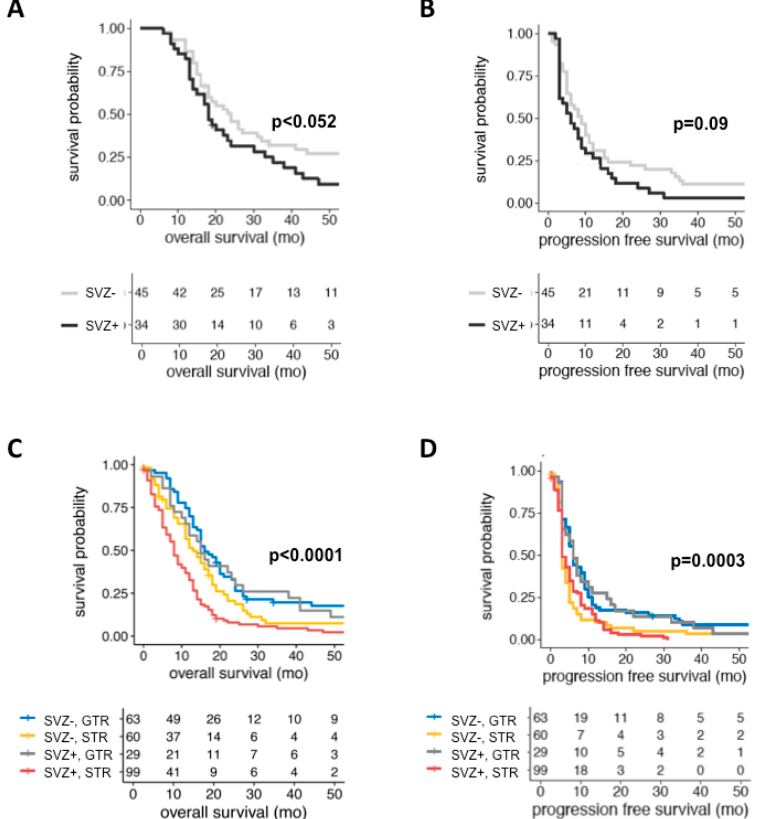
Figure 4. When analyzing IDH1-wt GBM patients with intensified adjuvant treatment (i.e., completion of concomitant radio-chemotherapy and ≥ 3 cycles of TMZ-based chemotherapy) only ( n = 79), absence of radiographic SVZ involvement conferred a non-significant, but meaningful prolongation of OS (24 vs. 18 months; A ) and PFS (9 vs. 6 months; B ) that also compared favorable to the outcomes of the most recent “historic control” derived from a multicenter trial on tumor-treating fields in newly diagnosed GBM [36] (OS = 16 months; PFS = 4 months; data not shown). ( C , D ) Kaplan-Meier plots depicting the prognostic significance of SVZ involvement in 285 IDH1-wt GBM patients on OS ( C ) and PFS ( D ) when stratified for EOR. Noteworthy, the negative prognostic impact of SVZ involvement can be, in part, resolved by GTR since OS and PFS were comparable in patients undergoing GTR regardless of SVZ involvement (OS: SVZ+GBM 15.5 months vs. SVZ − GBM = 16.5 months; PFS: SVZ+GBM 6.5 months vs. SVZ − GBM 6 months). A tabular overview of numbers at risk is given below each Kaplan-Meier